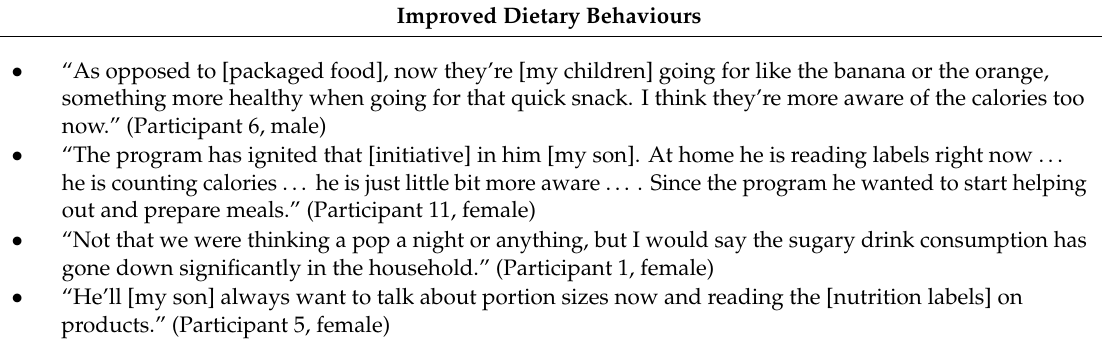
Table 2. Selected quotes related to parents’ perceptions of outcomes for